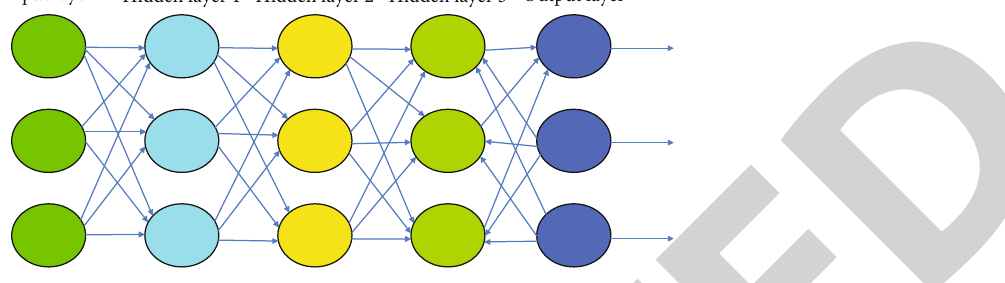
Figure 2: Structure diagram of feedforward neural